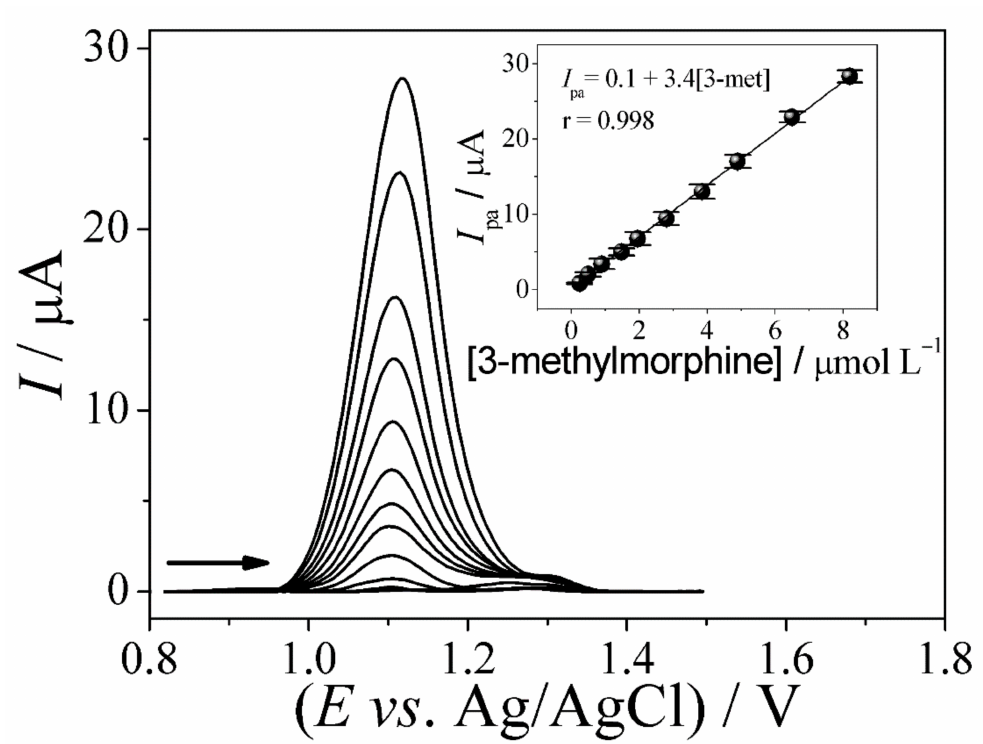
Figure 7. SW voltammograms obtained from the application of Bi-rGO-CTS/GCE for the deter- mination of 3-methylmorphine (concentrations ranging from 2.5 × 10 − 7 to 8.2 × 10 − 6 mol L − 1 ) in 0.04 mol L − 1 Britton–Robinson buffer solution (pH 4.0). Inset: Corresponding calibration plots related to 3-methylmorphine concentrations. Parameters: f = 15 Hz; a = 50 mV; ∆ E s = 5